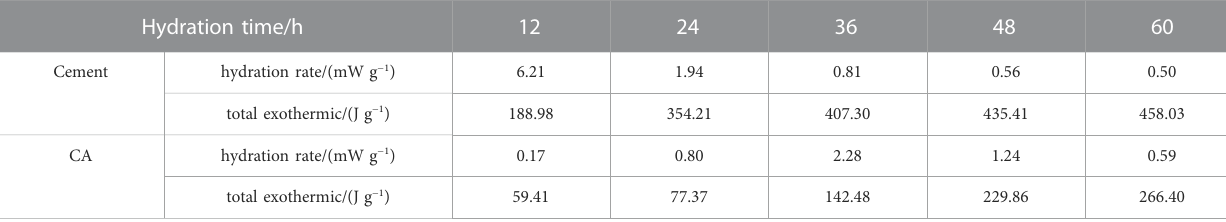
TABLE 4 Hydration rate and total exothermic of hydration at different hydration times.